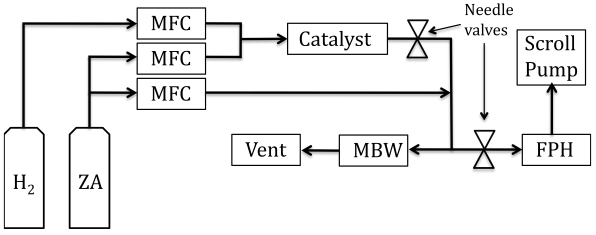
Fig. 1. Diagram of the components used for the dynamic dilution experiments. Two mass flow controllers (MFC) generated mixtures of H 2 in zero air (ZA), which passed through a Pt catalyst and nee- dle valve or critical orifice before mixing with additional zero air. The resulting H 2 O was measured with an MBW 373LX frost point hygrometer operated at ambient pressure, and a custom frost point hygrometer backed by a scroll pump and operated at approximately